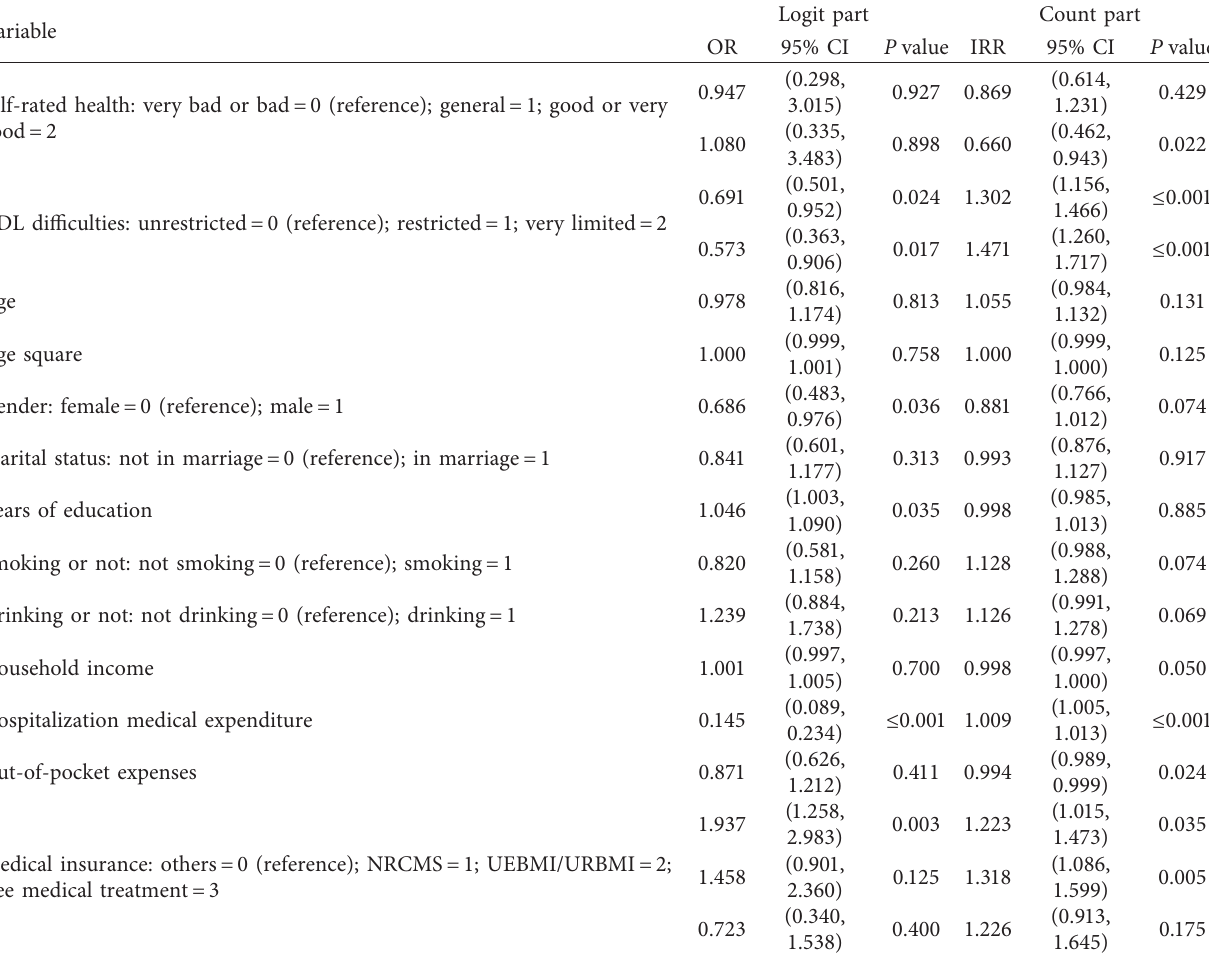
Table 3: Regression analysis of factors using the ZINB